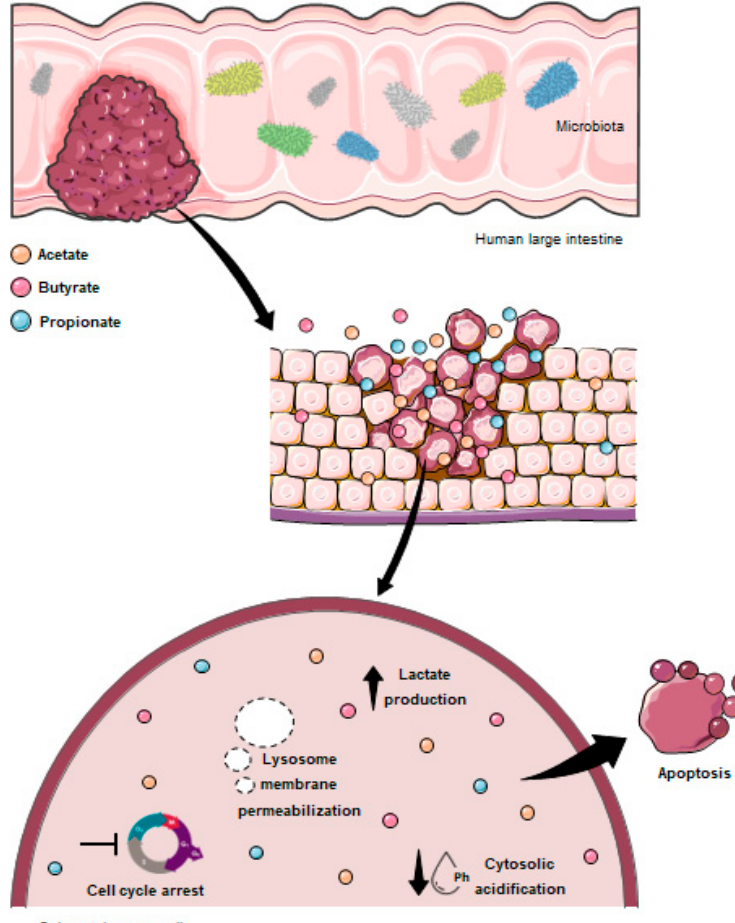
Figure 8. Schematic representation of the SCFA effects on CRC cells. Acetate (orange circle), butyrate (pink circle), and propionate (blue circle) derived from the intestinal microbiota are selective for CRC cells. Once inside the CRC cells, SCFAs interfere with several biological effects, namely inhibiting cell survival, inducing cell-cycle arrest and apoptosis, promoting LMP with a consequent cytosolic acidification, and, also, increasing lactate production.